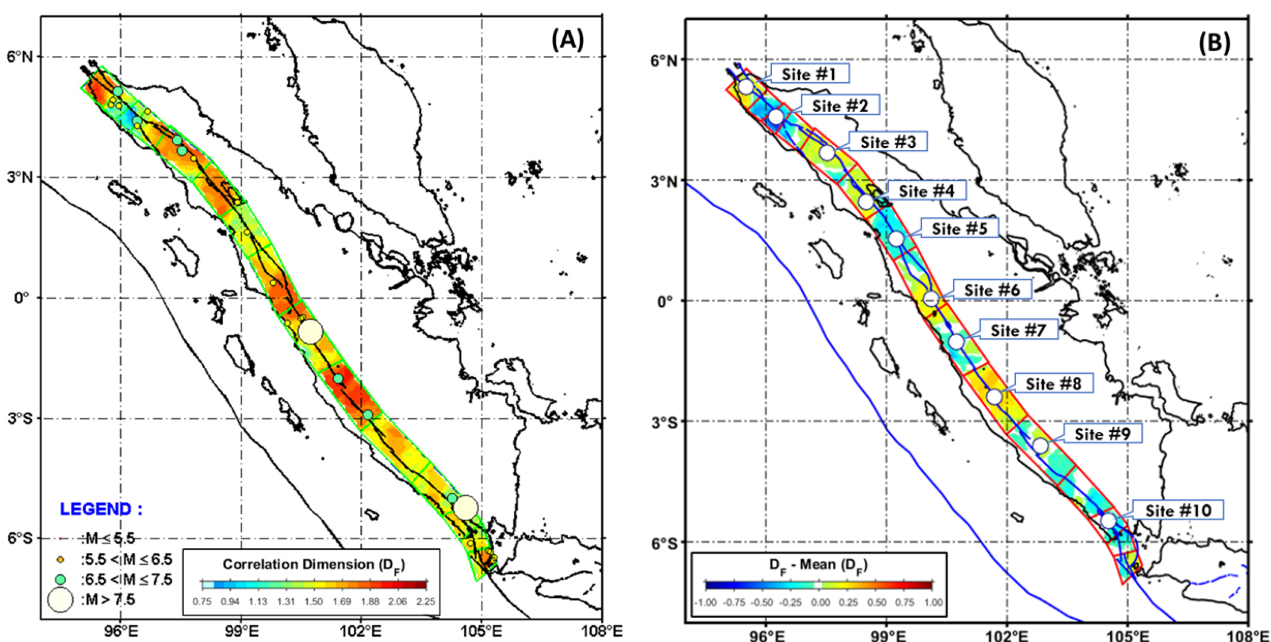
Figure 4. The map of D F overlay with the historical earthquake catalog with the M w ≥ 6.0 around the SFZ ( A ). D F is calculated using equation D F = 2.851 – 1.272b with the input of the b-value map Figure 2B. The map of (D F —mean of D F ) over the entire clustered zone boundary of Burton and Hall [21] and selected about ten sites to evaluate the SHF starting from the North-West to South-East ( B ). The relatively high D C coincides with the historical shallow large earthquakes data of Ref. [9] from 1925 to 2014.